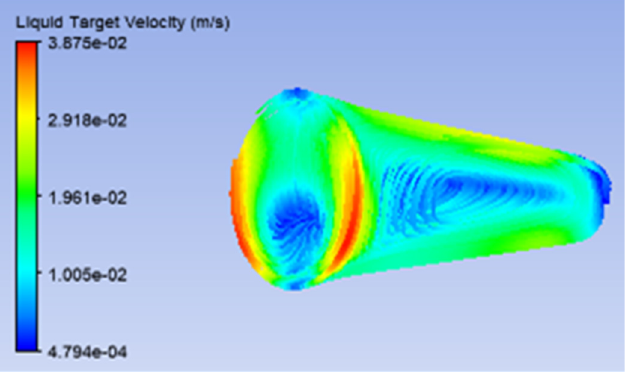
Figure 5. Velocity of the liquid target inside the target cavity with standard initial conditions. Figure 4. Velocity of helium inside its domain between the two windows, with standard initial conditions.